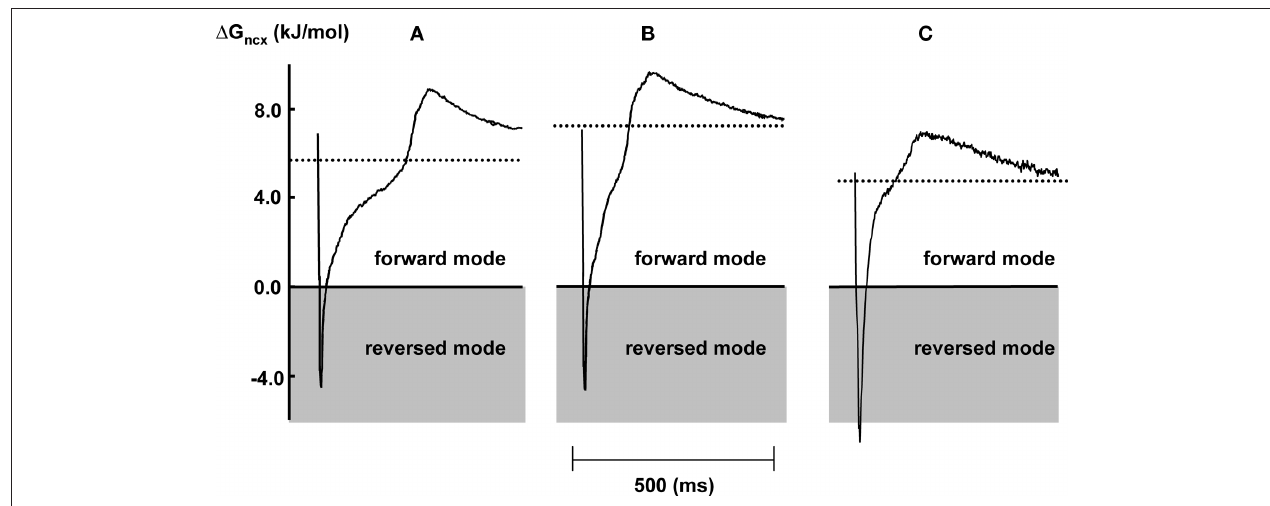
FiguRe 4 | Representative examples of the dynamic change of ∆ G (A) and after 2 (B) and 10 (C) min of metabolic inhibition. The dotted area corresponds to reversed mode operation of NCX. The dotted lines represent time averaged ∆ G over one stimulation cycle. ncx